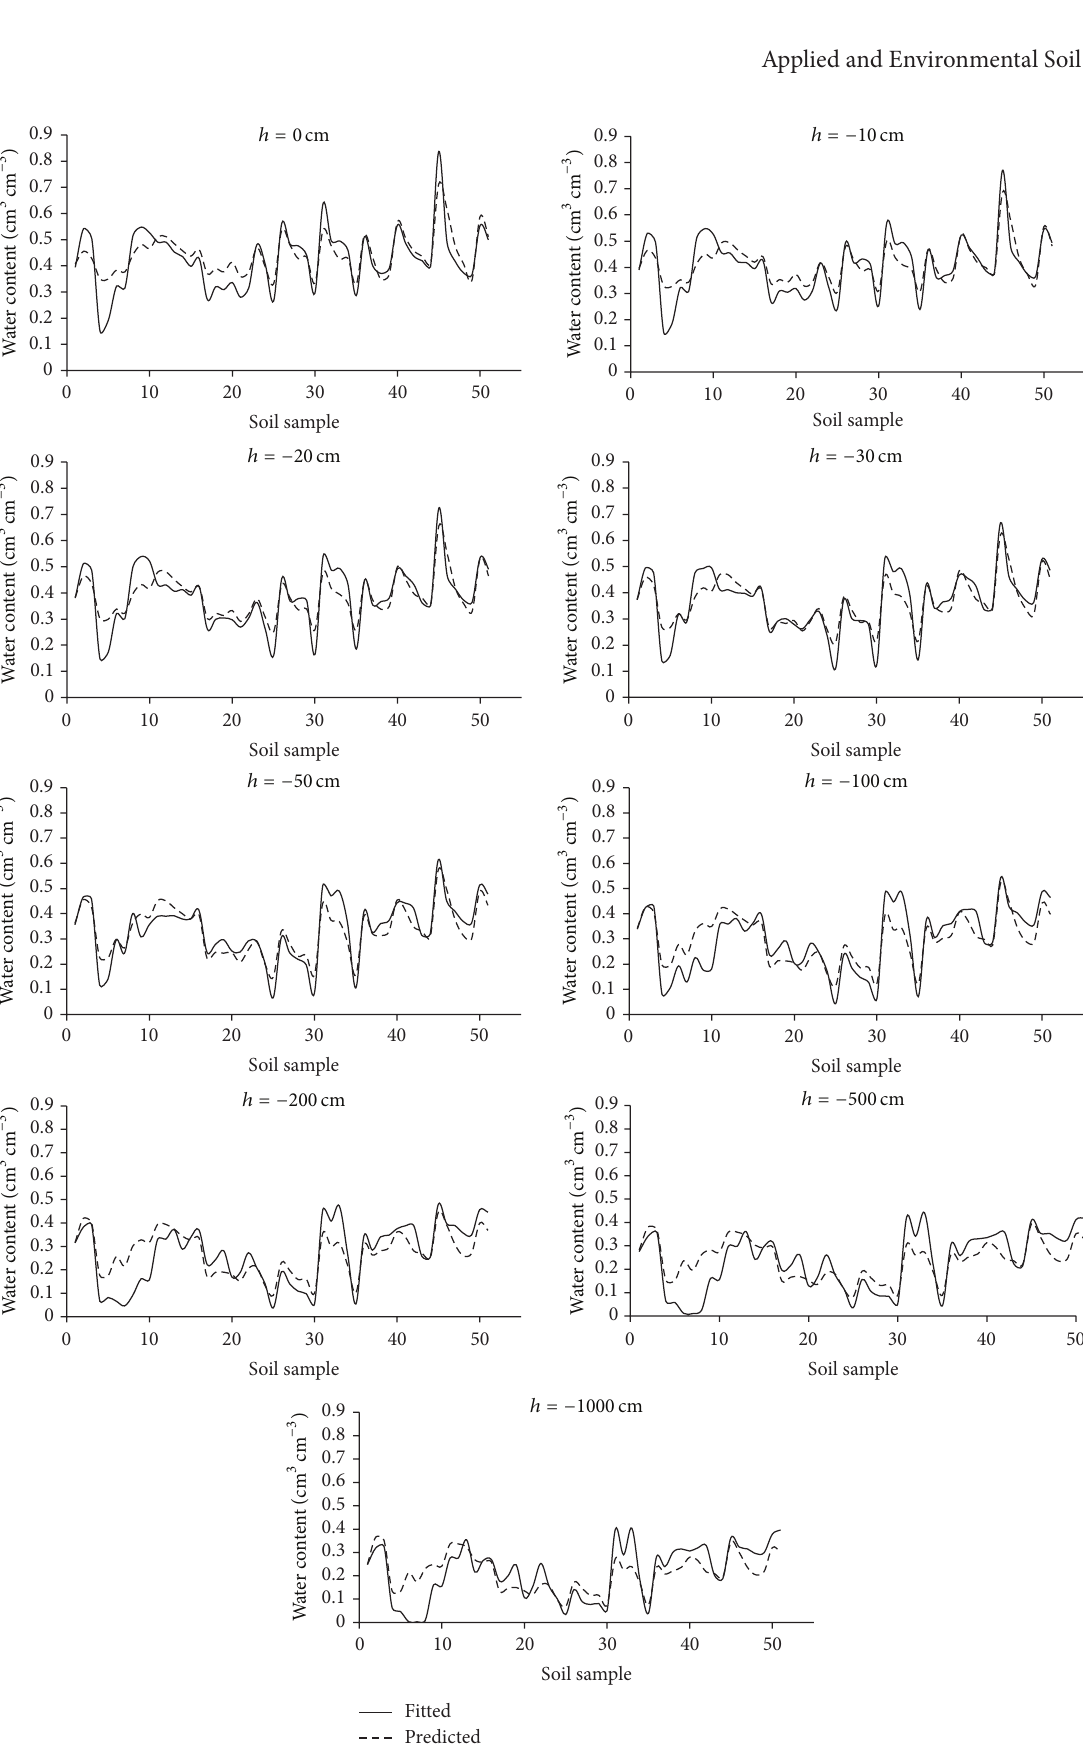
Figure 6: Fitted and predicted water contents obtained by ANN 1 model and van Genuchten parameters, respectively, where ℎ is the matric